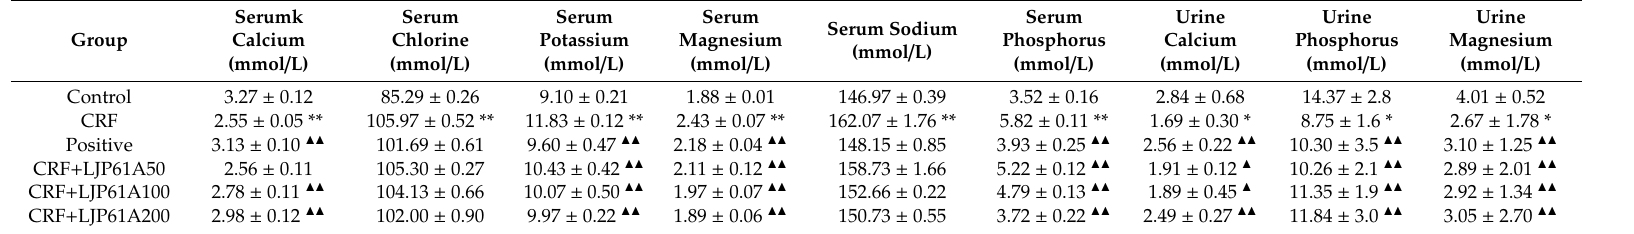
Table 1. LJP61A regulates the electrolyte disturbance of adenine-induced CRF